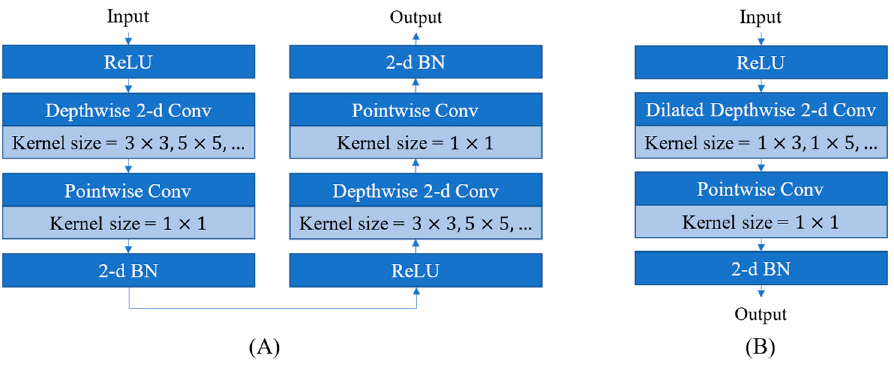
Figure 8. Architecture of ( A ) 2D DSCB; ( B ) 2D DiSCB.